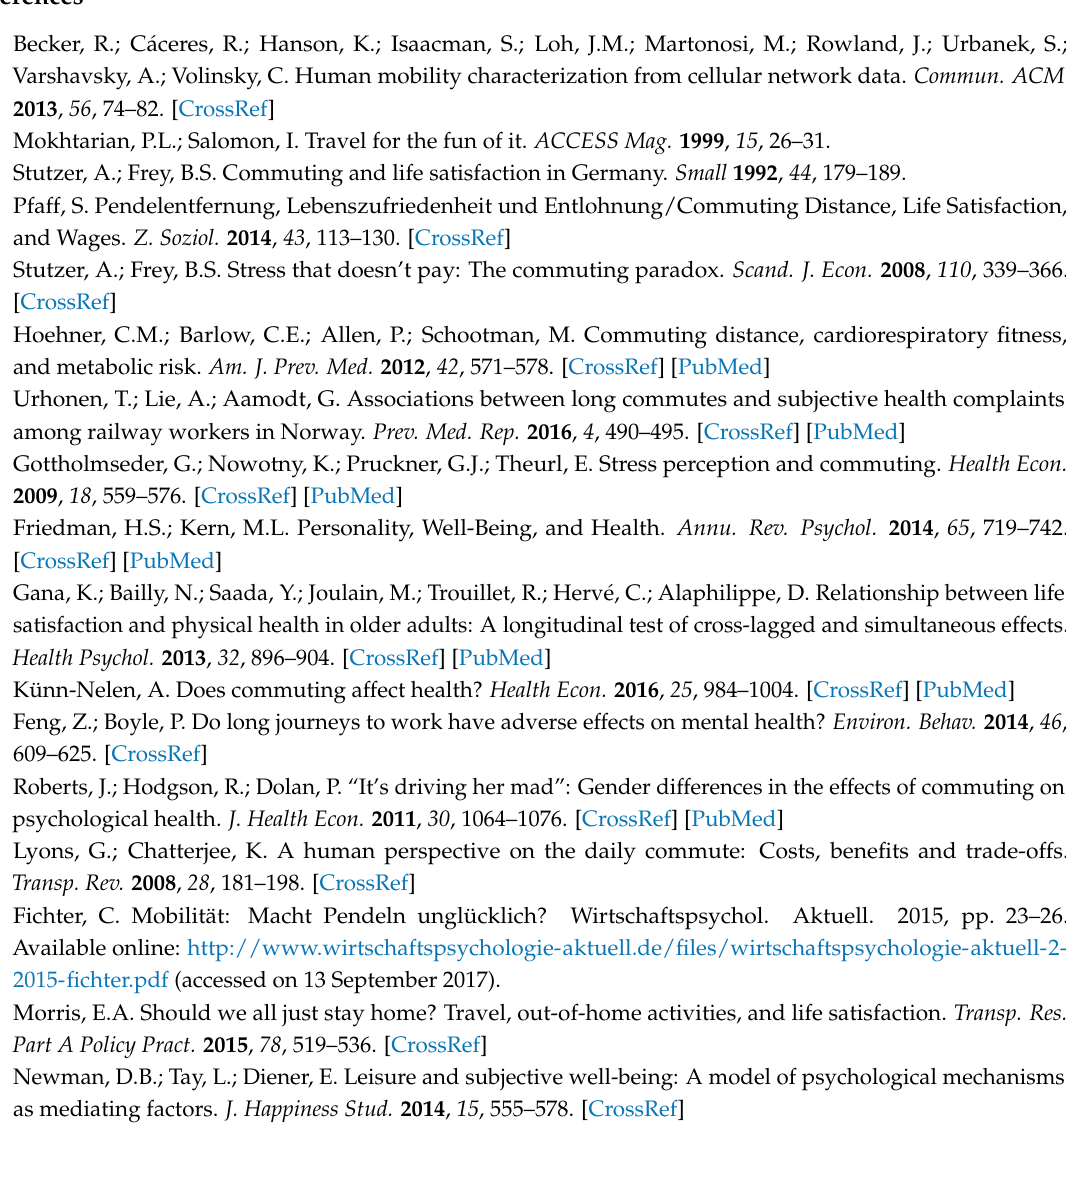
Table S1: Means and Standard Deviation, Minimum, Maximum, and Skew of personality variables for for the complete sample (CS) and non-commuters (NC), Table S2: Means and Standard Deviation, Minimum, Maximum, and Skew of personality variables for business-commuters (BC) and private commuters